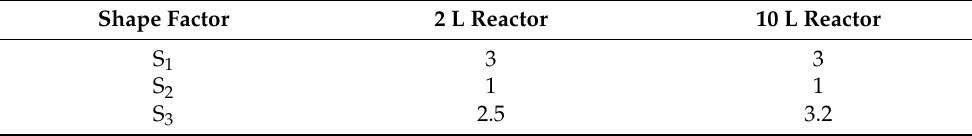
Table 3. Shape factors of laboratory and pilot plant scales .